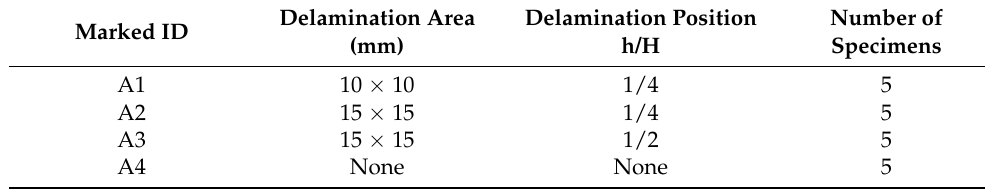
Table 1. Design of specimens with